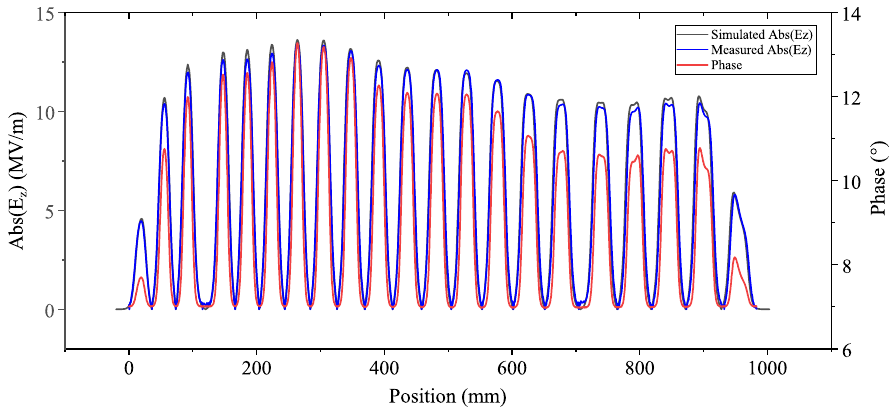
FIG. 6. Phase and electric field distribution along the beam axis. The black curve is the electric field distribution simulated in the absence of DT errors, and the blue and red curves are the electric field distribution and S 11 phase, respectively, measured by the bead perturbation method.